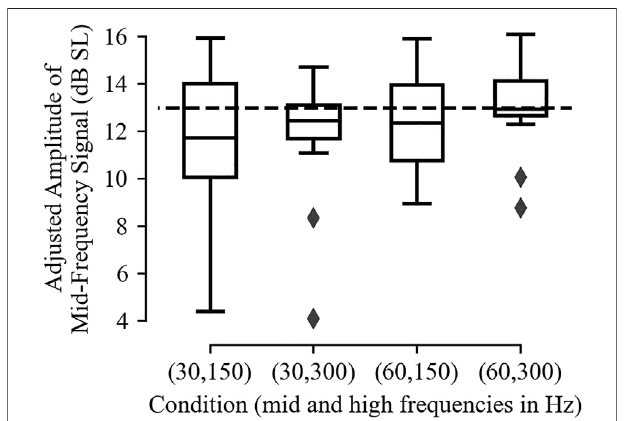
FIGURE8| Resultsofadjustedmid-frequencyamplitudesfromintensity matching. The horizontal dashed line corresponds to 13 dB SL.